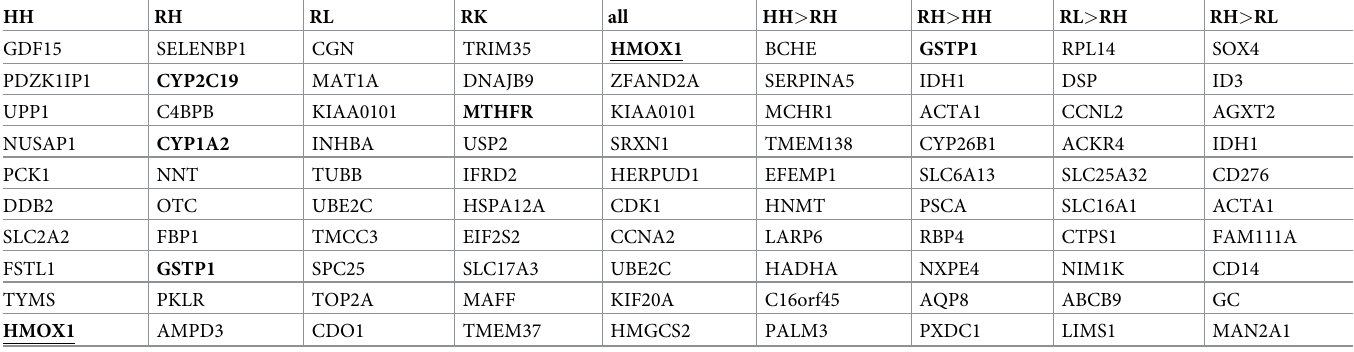
Table 1. Top 10 ranking genes for each model (HH, RH, RL and RK) and for combined rankings: Sum (all), and subtractions (HH > RH, RH > HH, RL > RH and RH > RL). Font indicates toxicity association by literature, bold for liver, underlined for kidney.